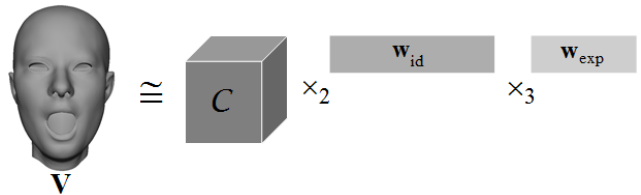
Figure 1. 3D face representation through the core tensor, identity and expression